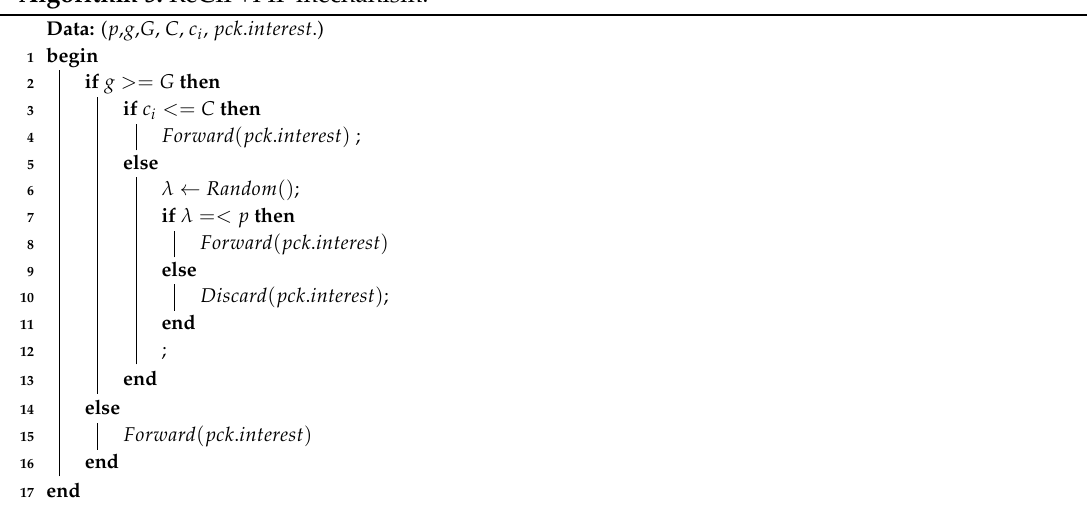
Algorithm 5: ReCIF+PIF